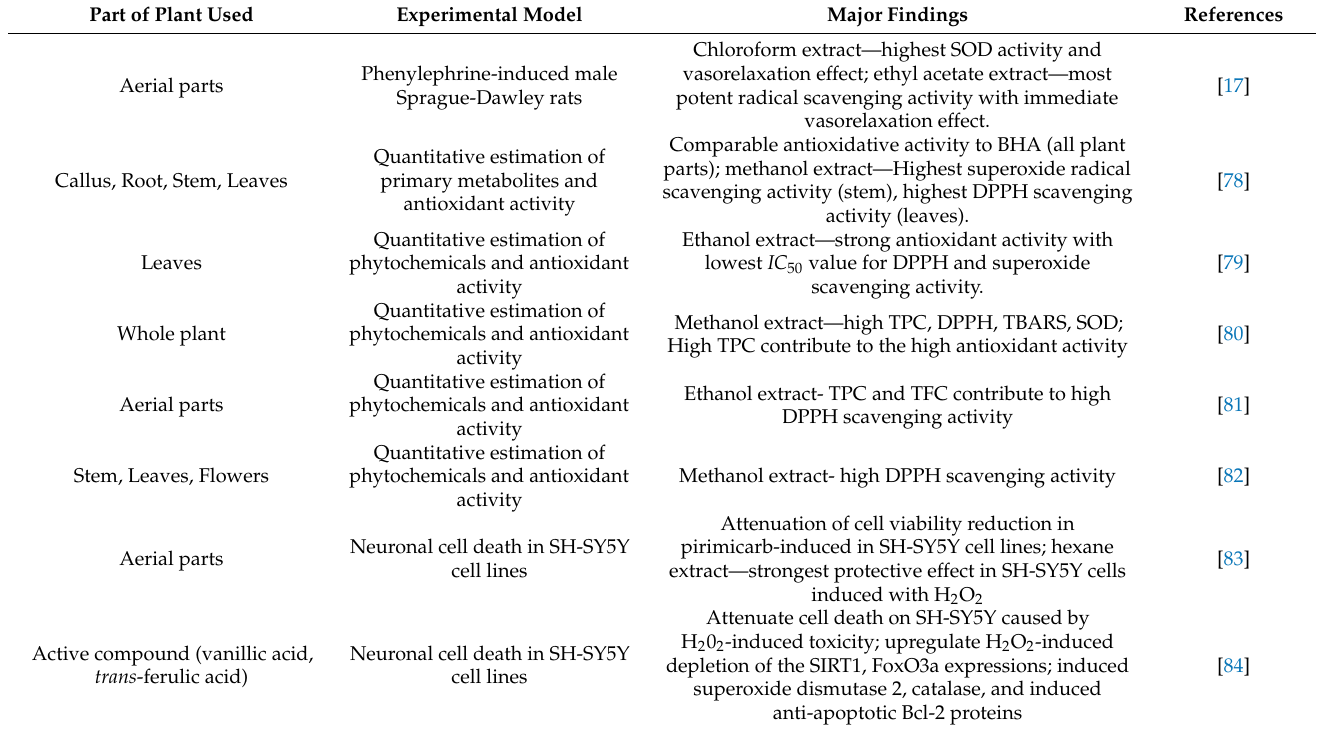
Table 4. Summary of antioxidant actions of S.